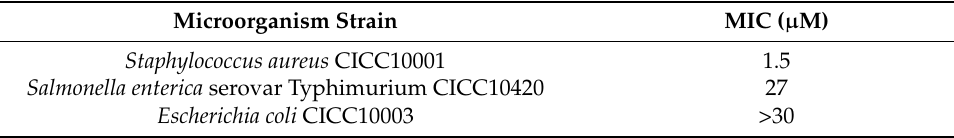
Table 3. Minimal inhibition concentration (MIC) of